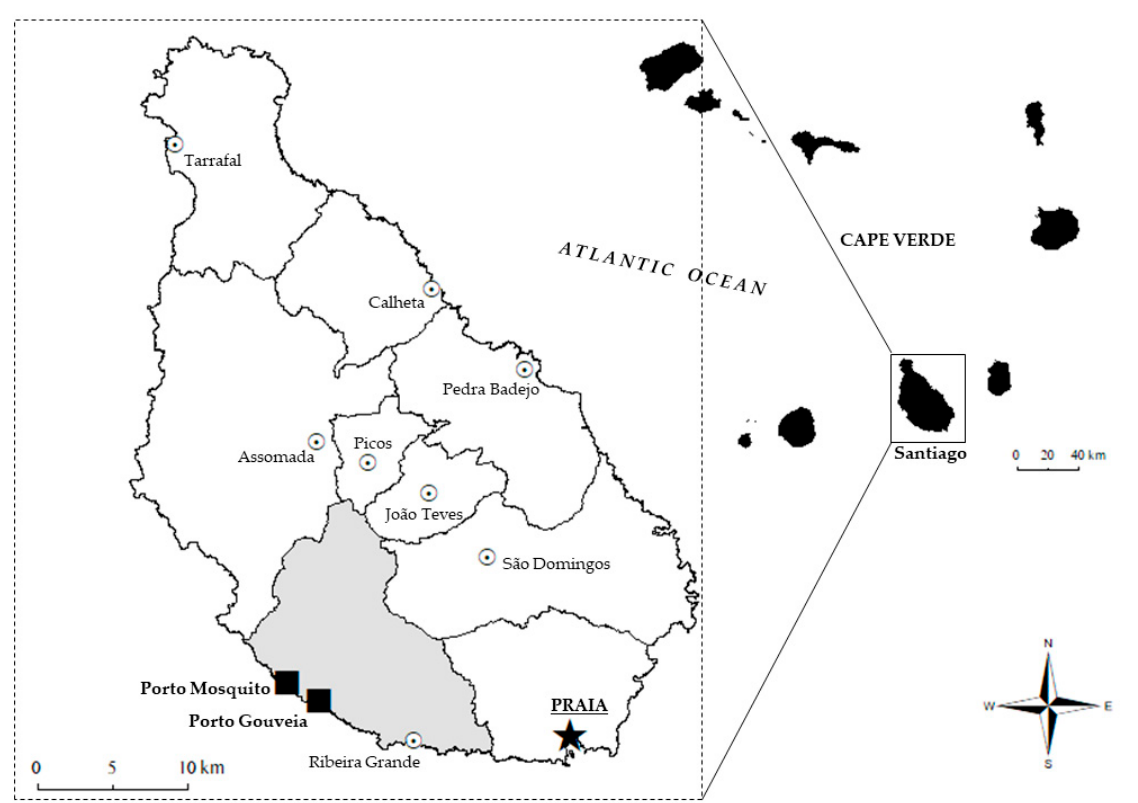
Figure 2. Porto Mosquito and Porto Gouveia (Data from: Humanitarian Data